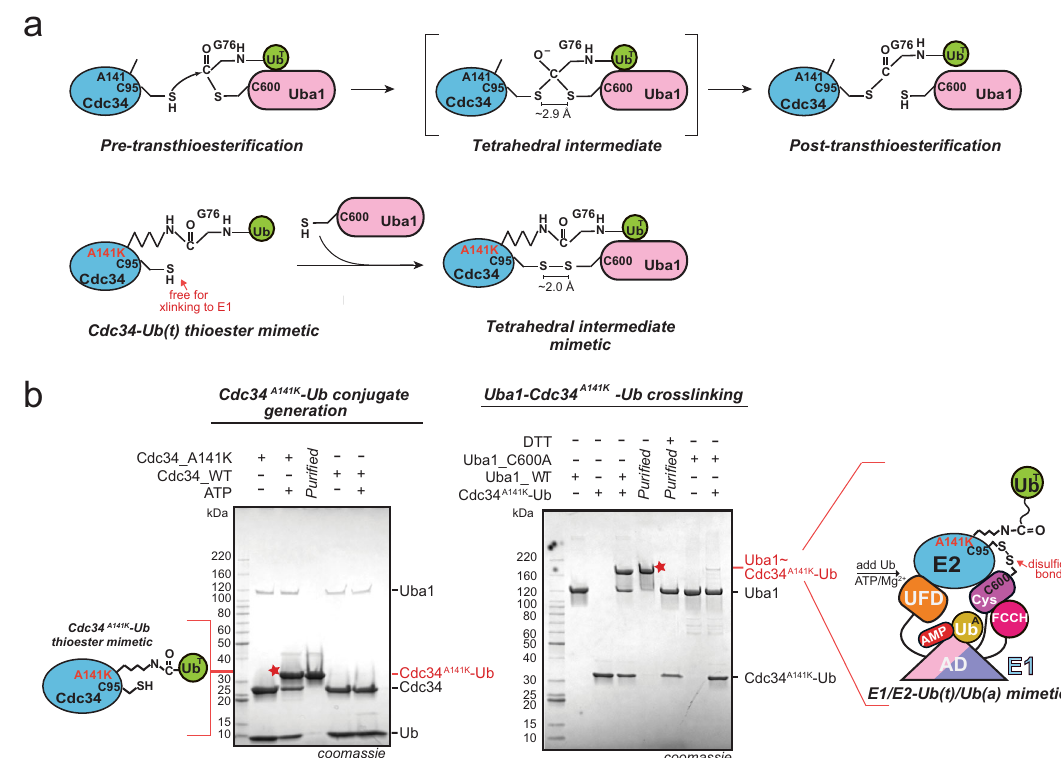
Fig. 1 Strategy of generating E1/E2 – Ub(t)/Ub(a) mimetic. a Schematic of the E1 – E2 thioester transfer intermediate and the mimetic used in this study. b Left, SDS-PAGE gel showing speci fi c production of Cdc34 A141K – Ub(t) conjugate in the presence of DTT. Right, Strategy to obtain Uba1/Cdc34 A141K – Ub (t)/Ub(a). Gel images are representative of independent technical replicates ( n = 2). Source data are provided as a Source Data fi analytical gel fi ltration shows that puri fi ed Uba1 – Cdc34 – Ub(t)